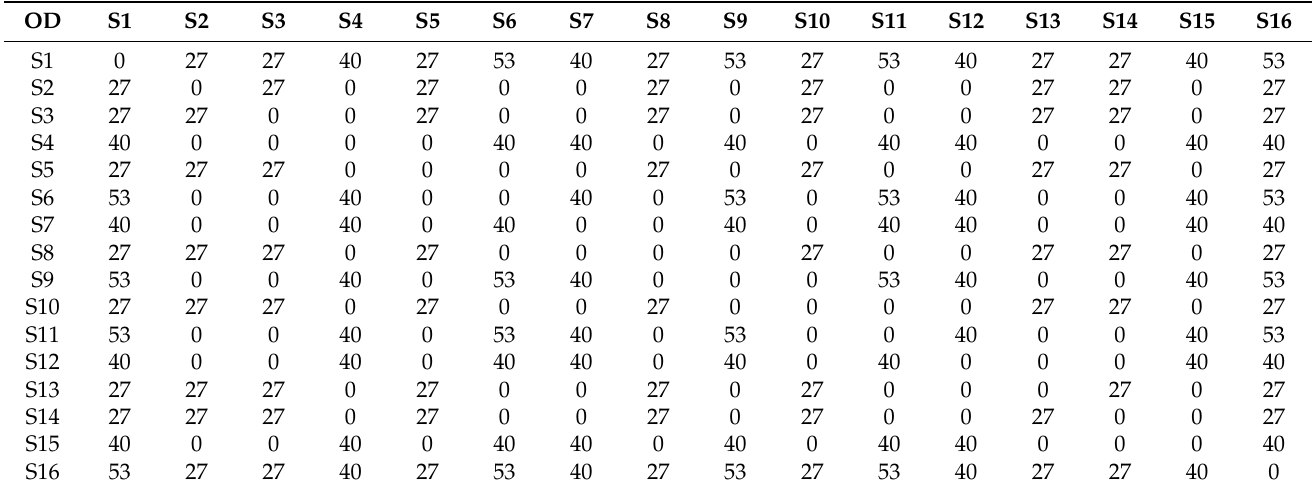
Table 5. The parameters of all OD service frequency in the whole